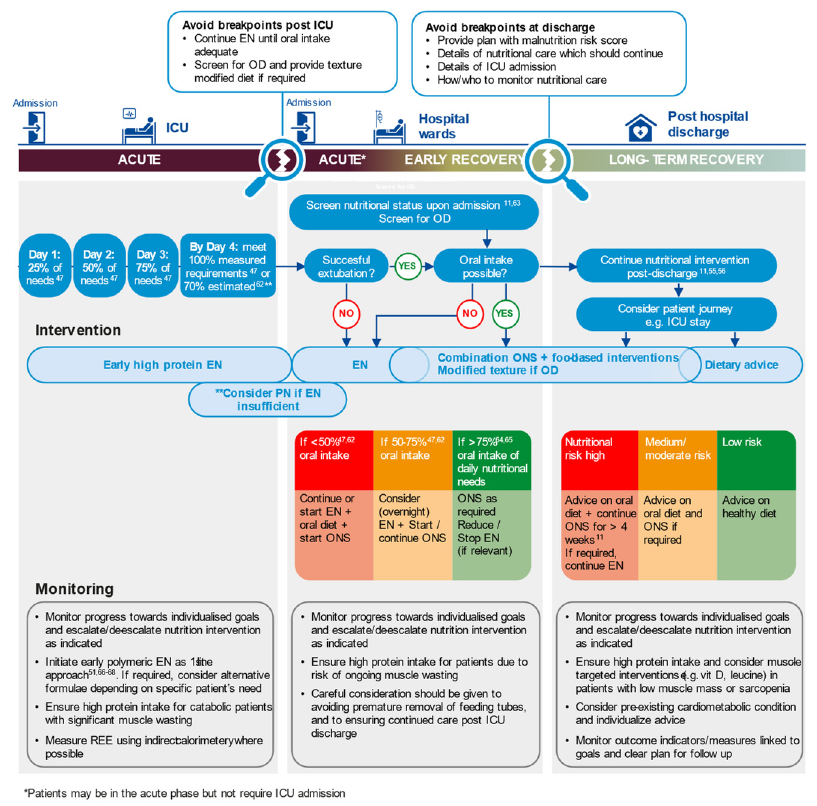
Figure 2. Assertive, multi-modal nutritional care individualised to meet patients’ needs across the continuum of care. EN, enteral nutrition; OD, oropharyngeal dysphagia; ONS, oral nutritional sup- plement; PN, parenteral nutrition; REE, resting energy